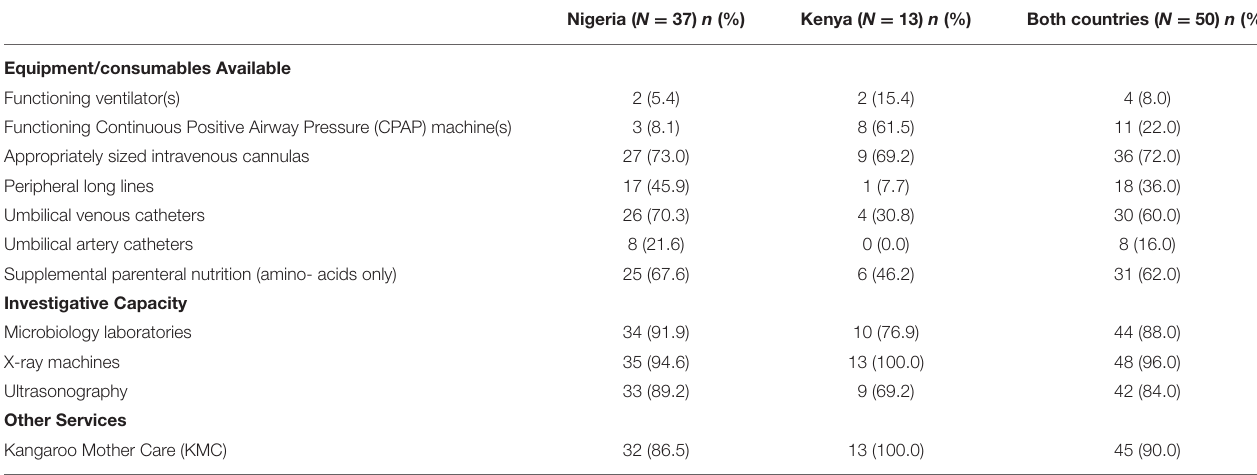
TABLE 2 | Level of care, investigations, equipment, and services available in the neonatal